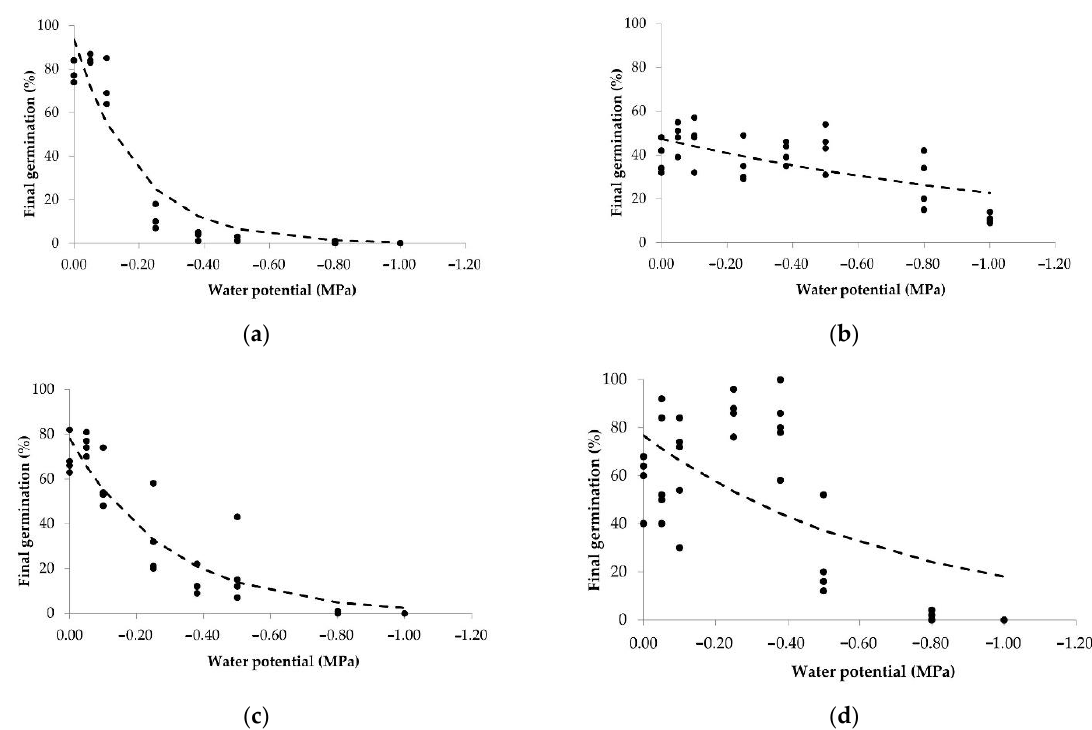
Figure 2. Final germination percentage of the studied weed species at different water potentials (MPa). The dotted line represents the regression line and the points the observed final germination percentages. Estimated functions are: ( a ) Amaranthus retroflexus y = 93.5 exp(−5.3x), r 2 = 0.90; ( b ) Chenopodium album y = 47.4 exp(−0.7x). r 2 = 0.45; ( c ) Panicum capillare y = 78.1 exp(−3.5x), r 2 = 0.87; ( d ) Setaria pumila y = 76.7 exp(−1.5x), r 2 = 0.46 .